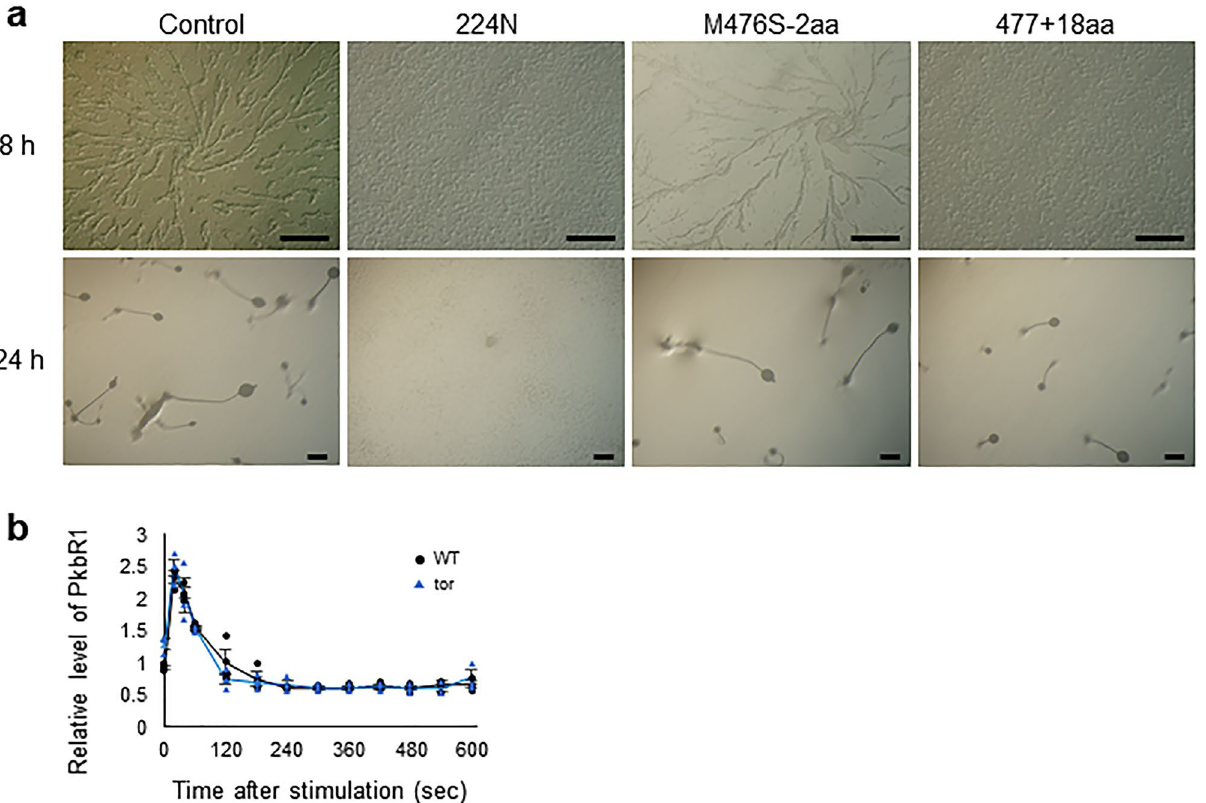
Figure 5. In-frame indel mutations in tor identified in the screens. ( a ) Developmental phenotypes of in-frame indel mutations in tor cells. The cells were plated on non-nutrient agar and imaged. Scale bars, 250 µm. ( b ) Chemoattractant-mediated activation of PKBR1 in 224 N tor mutants. Phosphorylated PkbR1 was analysed by immunoblotting and the band intensity was quantified. Mean values from three independent experiments and individual data points are shown. Error bars represent the